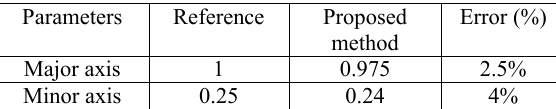
Figure 6. General procedure for curve structure reconstruction